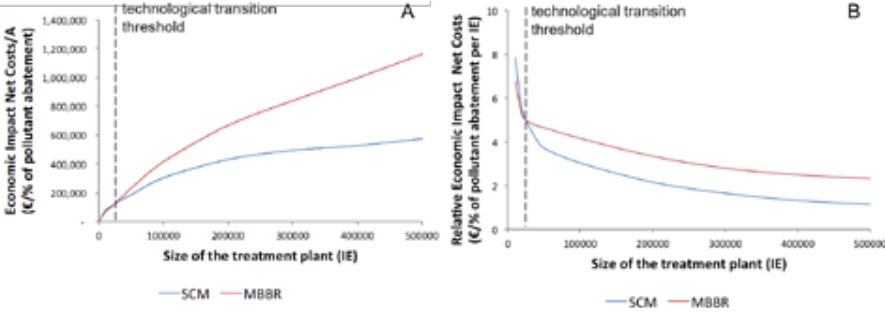
Figure 3. Economic impact trends of two alternative treatment processes with increasing size of the treatment plant: Absolute (A) and Average (B)